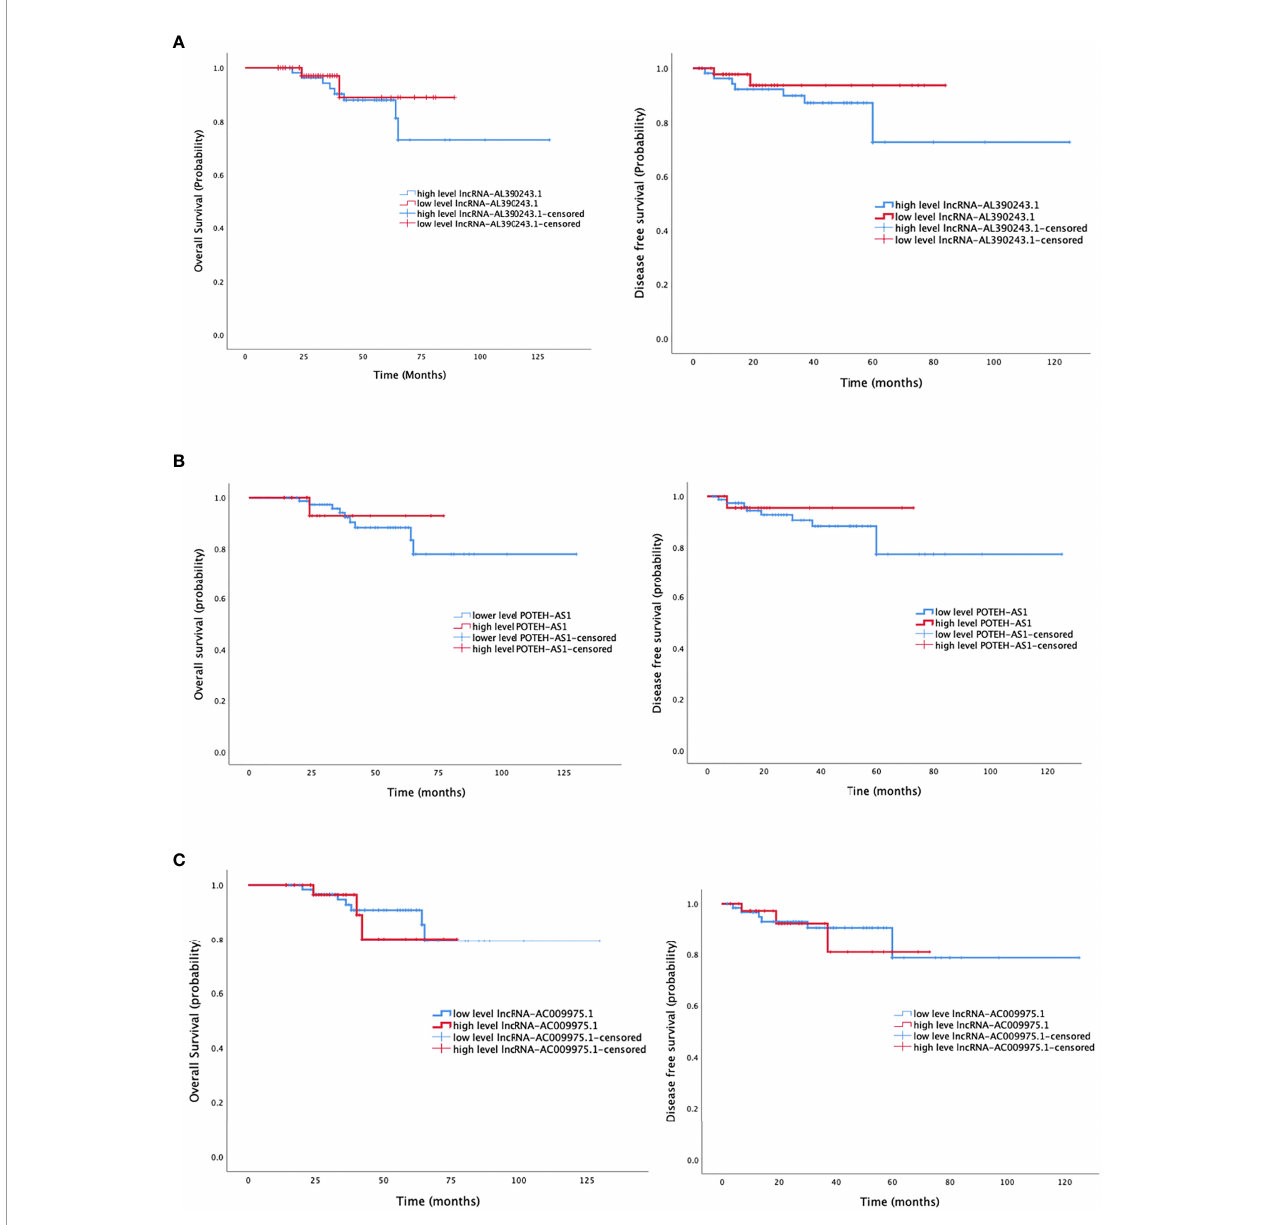
FIGURE 5 | The survival analysis of three lncRNA. (A) The overall survival and disease-free survival of lncRNA-AL390243.1. (B) The overall survival and disease-free survival of POTEH-AS1. (C) The overall survival and disease-free survival of